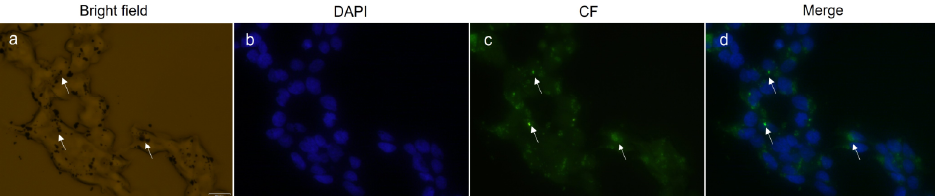
Figure 6. Bright field image of HEK 293T cells containing Ca 0.2 Mn 0.8 Fe 2 O 4 NPs ( a ), cellular nucleus stained with DAPI (blue) ( b ), NPs coupled with CF (green) ( c ), and overlay of DAPI fluorescence and fluorescence of CF coupled to the NPs ( d ). The white arrows indicate agglomerates of NPs inside the cell. Images were obtained by fluorescence microscopy using a 40× objective. The scale bar corresponds to 20 µm and all images have the same scale.